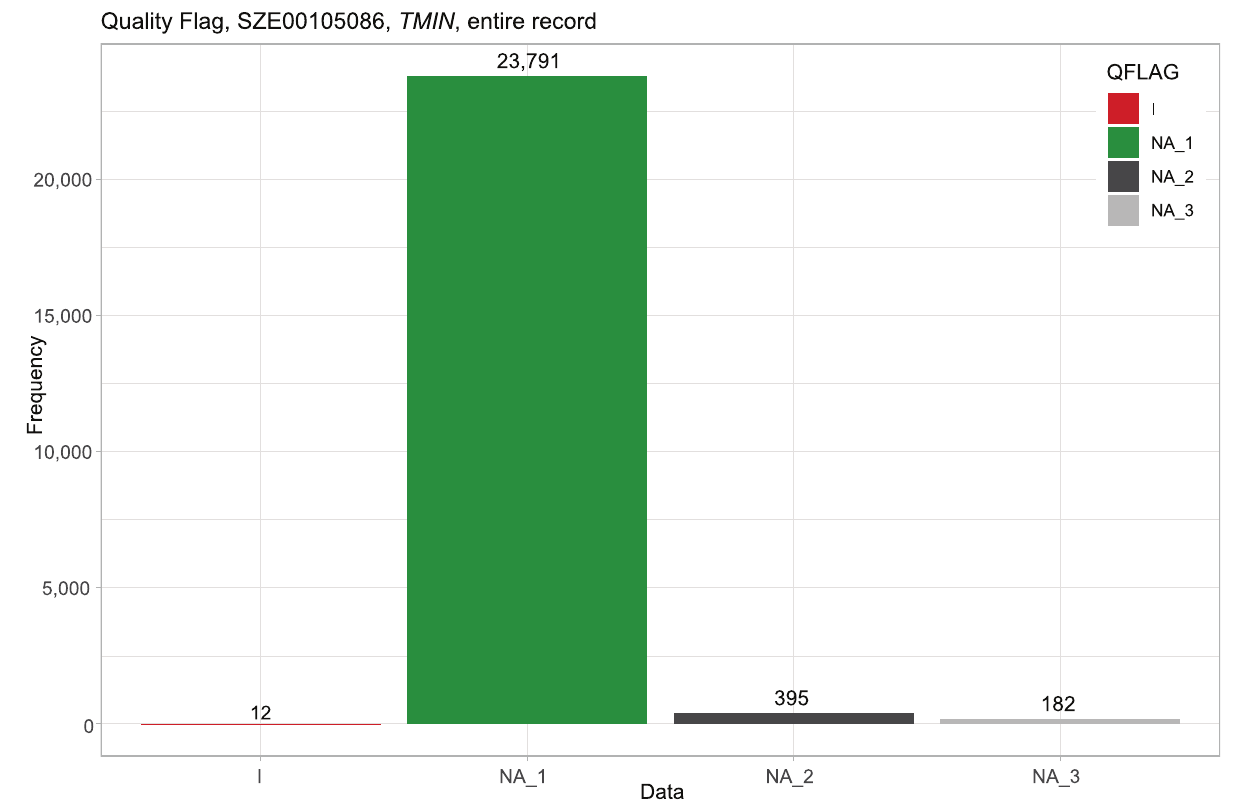
FIGURE 8 | Example data quality plot for station SZE00105086 generated using the script developed. NA_1 means that there is a real (i.e., non-NA) value in for the corresponding observation, and so a blank quality flag (QFLAG) entry indicates no quality problems, NA_2 means that a given day was present in the original file but there was no valid observation (i.e., observation was NA), and NA_3 denotes records for days between the first and last records that were not present in the original file, and for which NAs were inserted (i.e., the record was “padded” to produce a continuous time stamp column). “I” indicates “failed internal consistency check”. For a full list of possible quality flags, see the GHCNd metadata information (“readme.txt”). The script also enables users to make arbitrary temporal subsets of any data